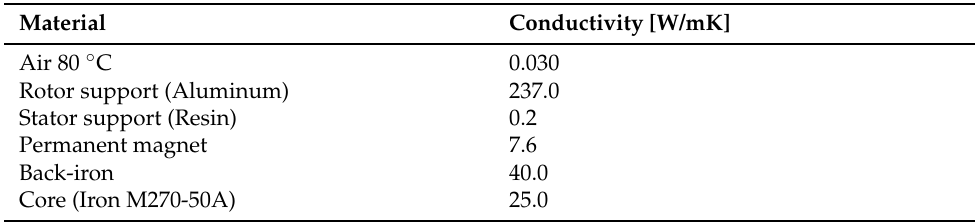
Table A1. Thermal properties of the different materials in the AFPM machine.